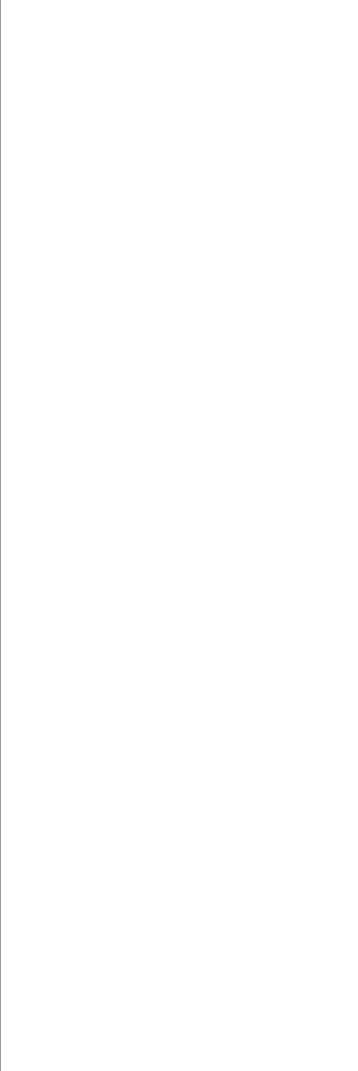
FIGURE 6 | Expression of proteins of the PI3K/PAkt/mTOR/autophagy signaling pathway. (A) expression of PI3K, (B) phosphorylated Akt (p-Akt), (C) mTOR, (D) phosphorylated mTOR (p-mTOR), (E) S6K1, (F) phosphorylated-S6K1 (p-S6K1), (G) LC3-II/LC3-I, expressed as the ratio of LC3-II to LC3-I, (H) Beclin-1, (I) p62. Upper: representative blots of each protein, GAPDH was used as the internal reference; bottom: densitometry analysis of each protein. Each bar presents the Mean ± SEM, n = 5 – 8. * P < 0.05 compared with normoxia group, # P < 0.05, compared with hypoxia